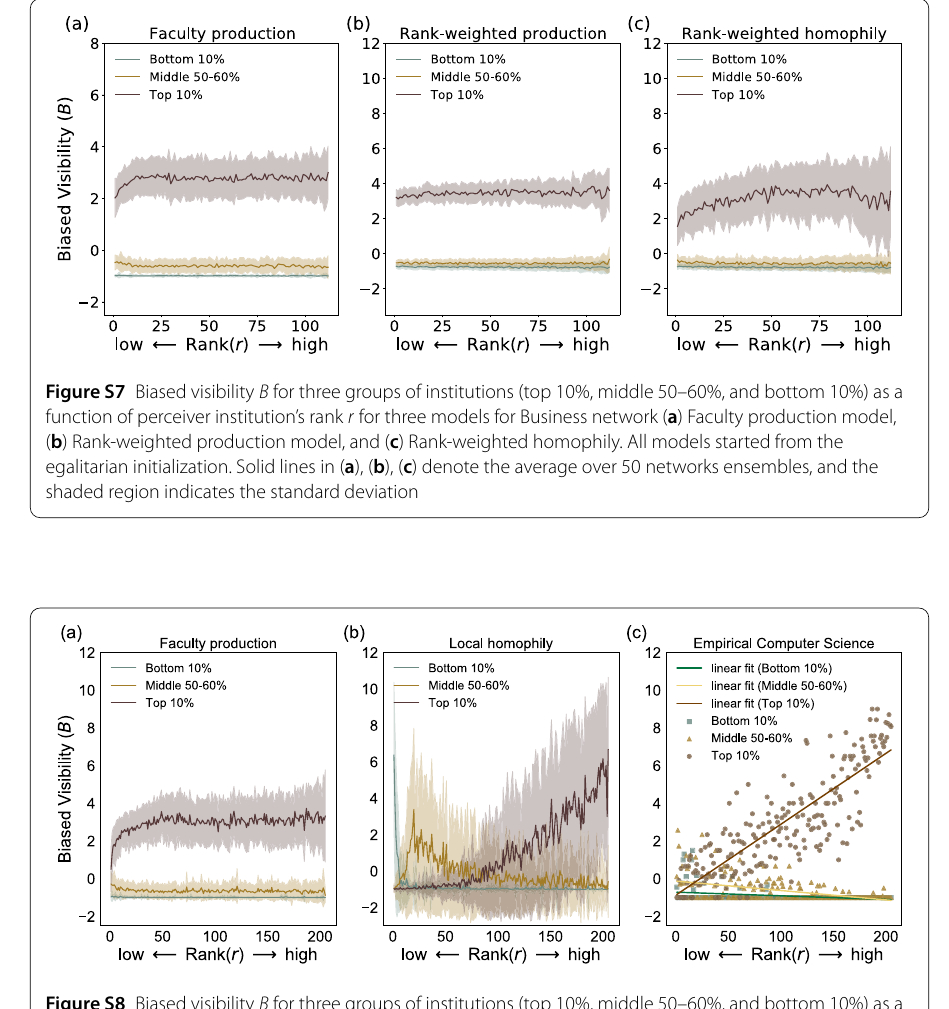
Figure S8 Biased visibility B for three groups of institutions (top 10%, middle 50–60%, and bottom 10%) as a function of perceiver institution’s rank r for two models and the empirical Computer Science network ( a ) The Faculty production model, ( b ) Local homophily model, and ( c ) the empirical Computer Science hiring network where each point is a department and lines indicate the best linear fit to the corresponding data. All models are from skewed initialization. Solid lines in ( a ), ( b ) denote the average over 50 networks ensembles, and the shaded region indicates the standard